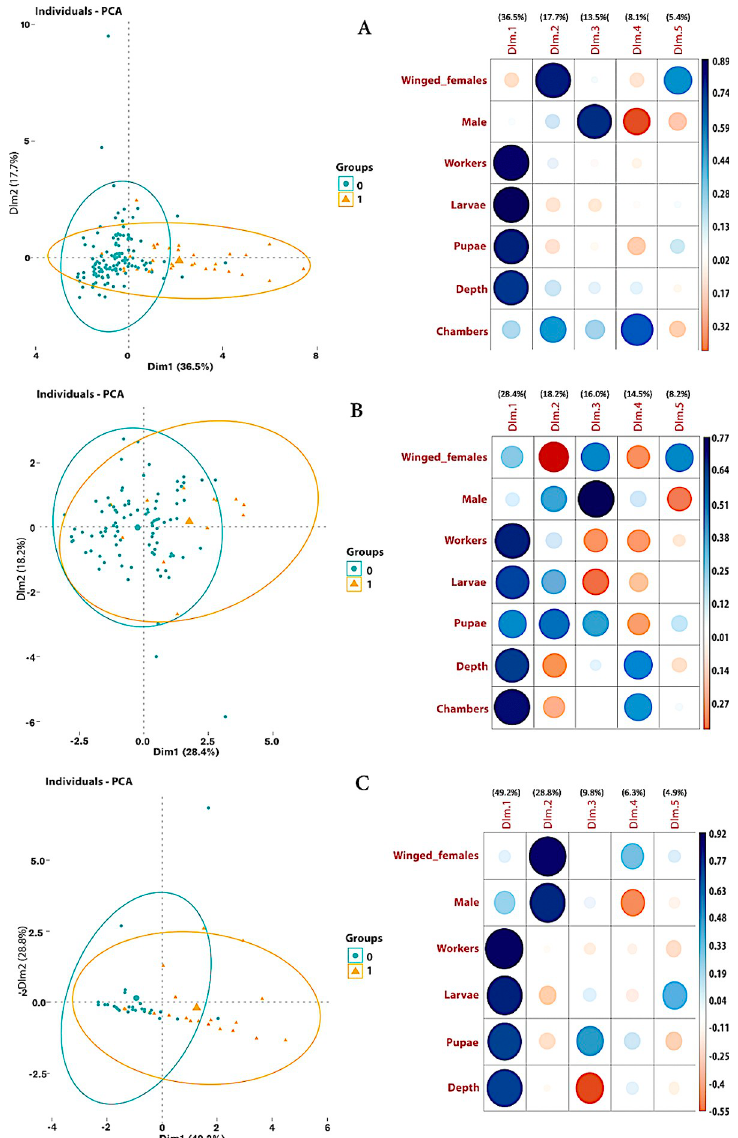
Fig 5. Principal Component Analysis (PCA) including all structural and population variables of excavated nests according to the presence or absence of a queen. Blue circles (0) represent queenless nests, and orange triangles (1) queenright nests. Dimensions 1 and 2 correspond to the two main axes of the PCA, with the highest eigenvalues, i.e. those that explained most of the variance in the system. (A) PCA using data from the 152 complete nests excavated; (B) PCA using the data from the 103 complete nests excavated at ‘Cali’; (C) PCA using data from the 49 complete nests excavated at ‘Cauca’. For each of the three plots at the right side of the figure, the size of the circles represents the amount of the effect of each dimension and each variable, while the intensity of their color represents the strength of the correlation. The blue color becomes more intense as the positive correlation gets stronger, while the red color becomes more intense as the negative correlation